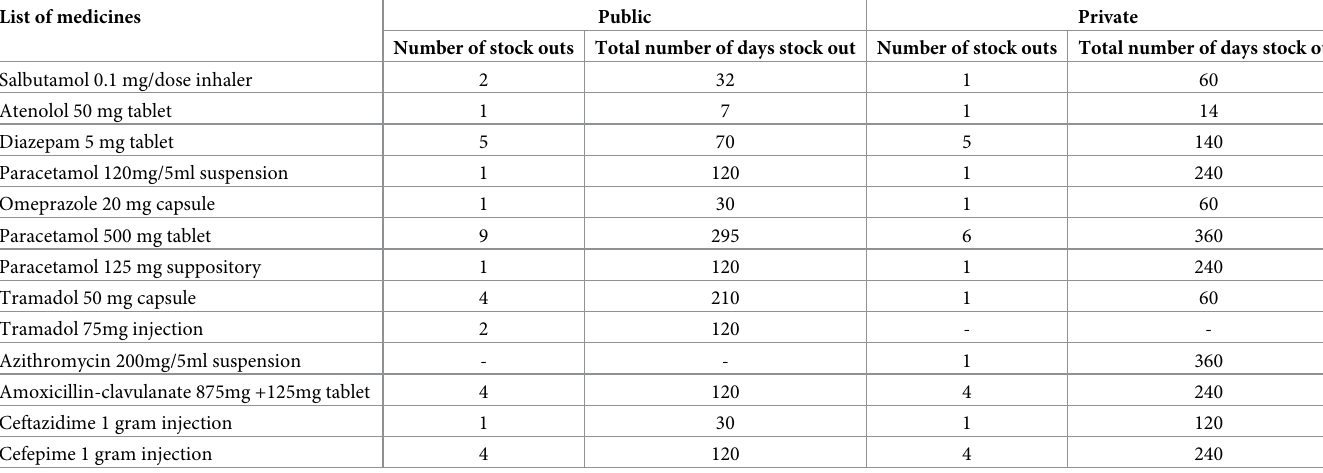
Table 3. Number of stock outs and the total number of day’s stock out of medicines in health facilities of Dessie town, 2021. List of medicines Public